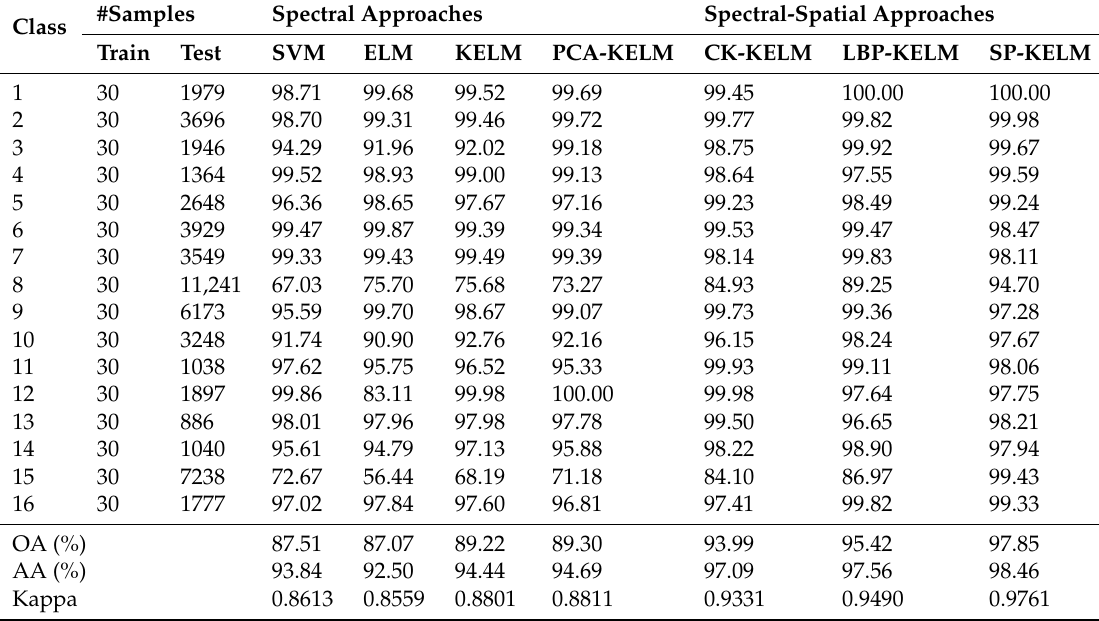
Table 4. Performance comparison of all compared methods on the Salinas Scene